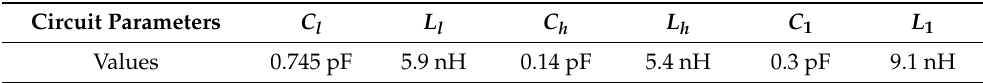
Table 1. Lumped parameters of